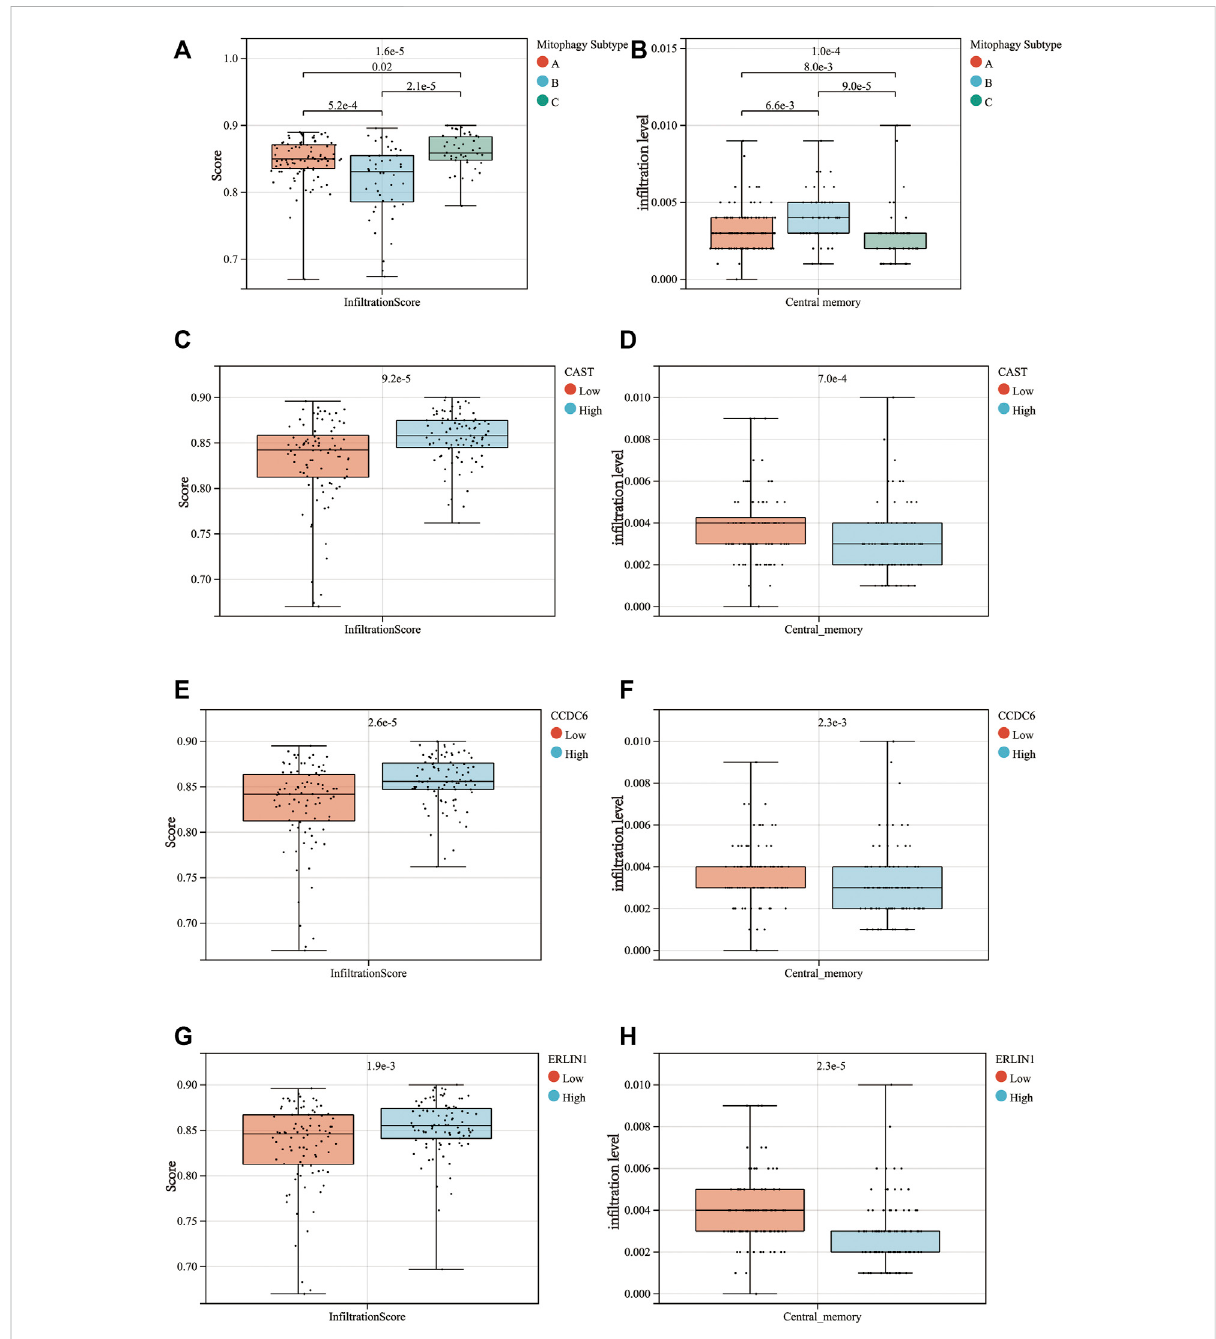
FIGURE 9 Differencesinthein fi ltrationscore (A) andthecentralmemoryin fi ltration (B) amongthe3mitophagysubtypes( p -valueswerecalculatedbythe Kruskal Wallis test). Differences in the in fi ltrationscore and the central memory in fi ltration between the high and low groups of CAST (C,D) , CCDC6 (E,F), and ERLIN1 (G,H) ( p -values were calculated by the Wilcoxon